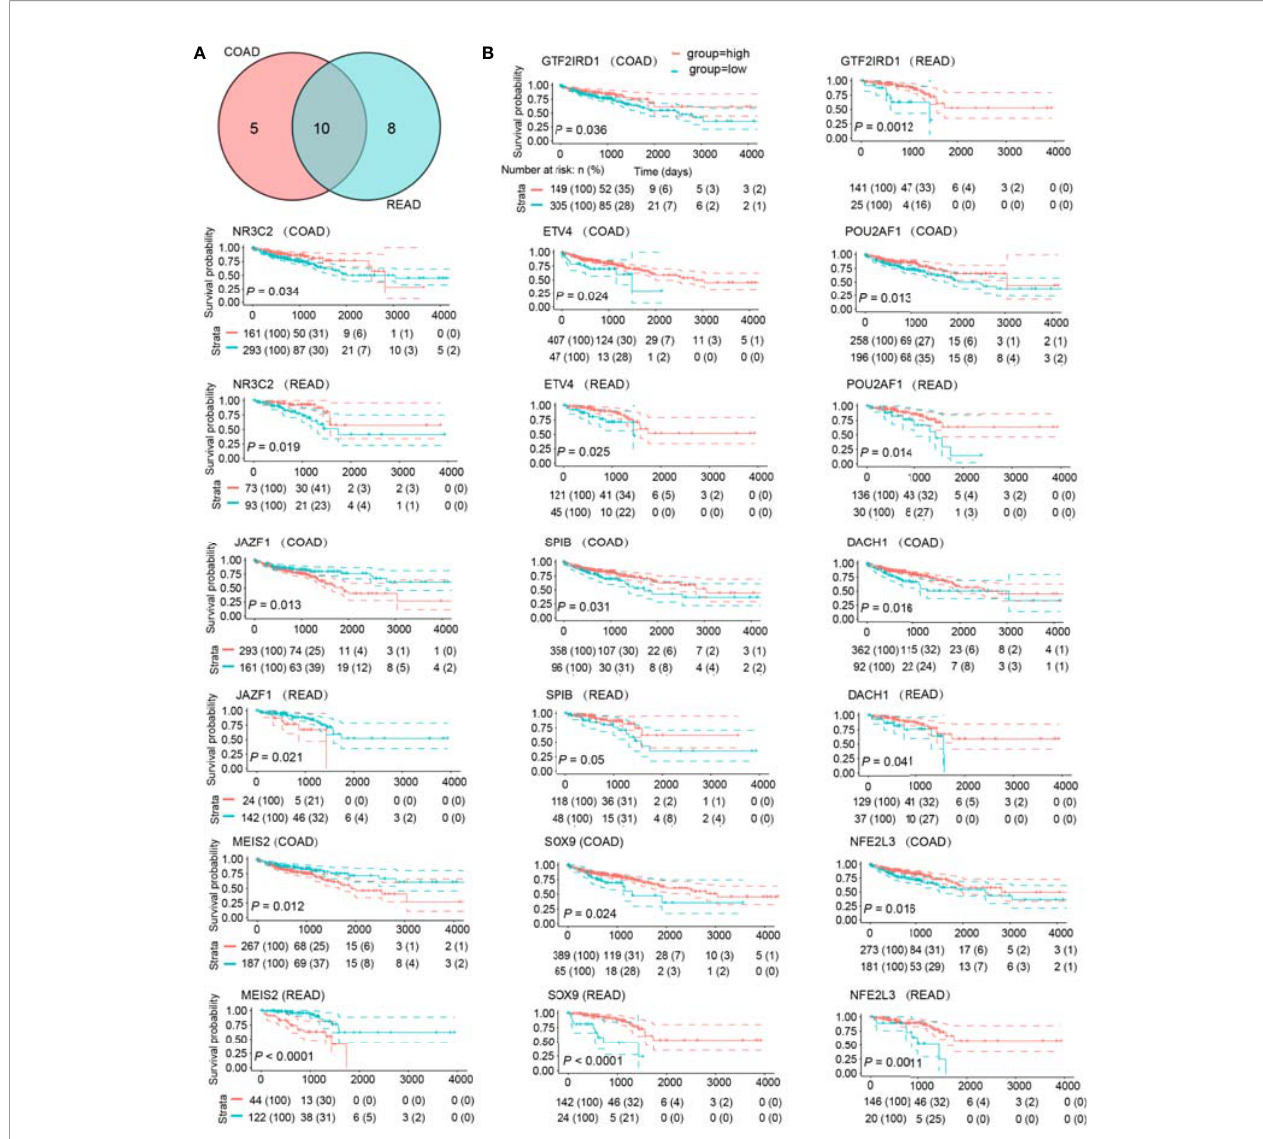
FIGURE 3 | DE-TFs of signi fi cance in survival analysis. (A) Venn diagram determined ten commonly shared DE-TFs by COAD and READ which possessed signi fi cant prognostic value. (B) The overall survival curves of these ten DE-TFs in COAD and READ were depicted by Kaplan-Meier method. Patients were grouped into “ High ” and “ Low ” depending on the gene expression value with the best